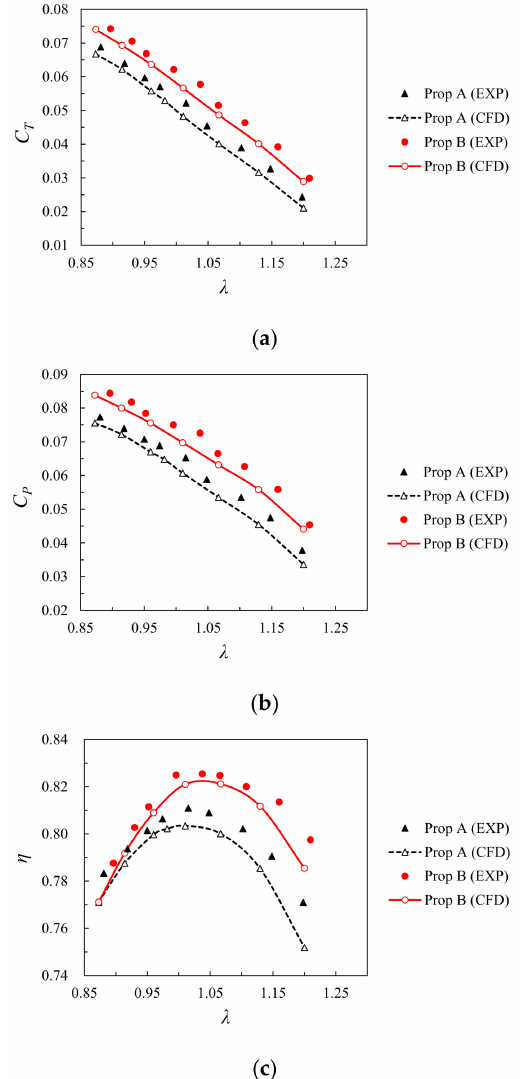
Figure 28. Comparison of the test and CFD results under Re ≈ 4 × 10 4 : ( a ) Thrust coefficient vs. advance ratio; ( b ) Power coefficient vs. advance ratio; ( c ) Propeller efficiency vs. advance